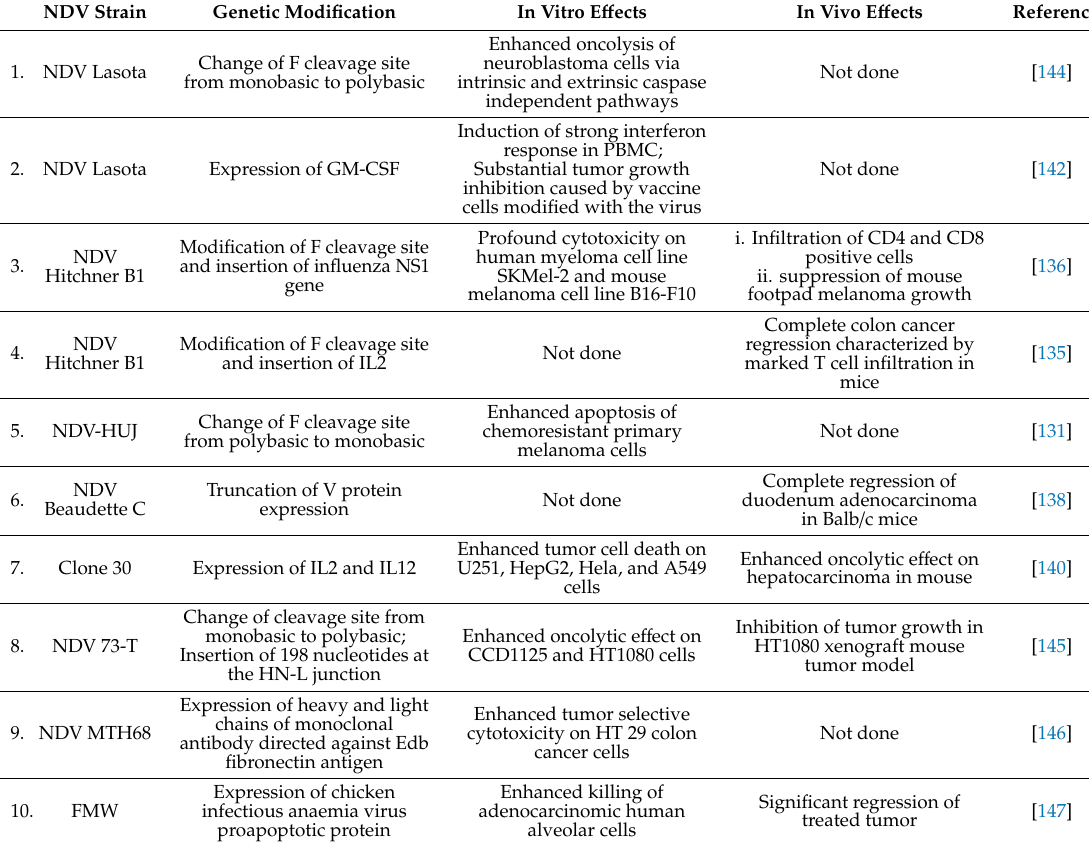
Table 2. Some strategies used to enhance the oncolytic e ffi cacy of Newcastle disease virus. NDV Strain Genetic Modification In Vitro E ff ects In Vivo E ff ects